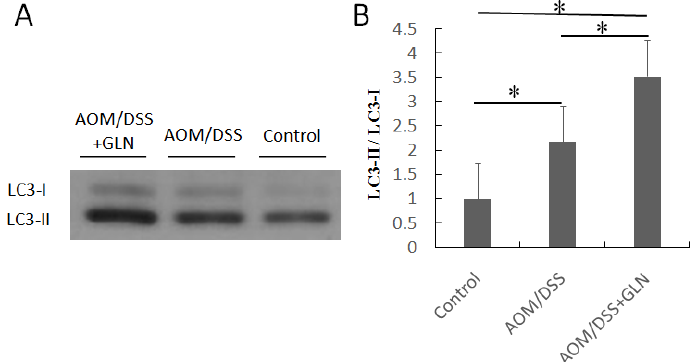
Figure 4. Effects of GLN on autophagy. Increased expression of LC3 ‐ II protein by GLN in AOM/DSS treated mice ( A ); The ratio of LC3 ‐ II/LC3 ‐ I proteins was statistically analyzed by densitometry ( B ). Data are presented as means ± SD. * Statistical differences with p < 0.05.